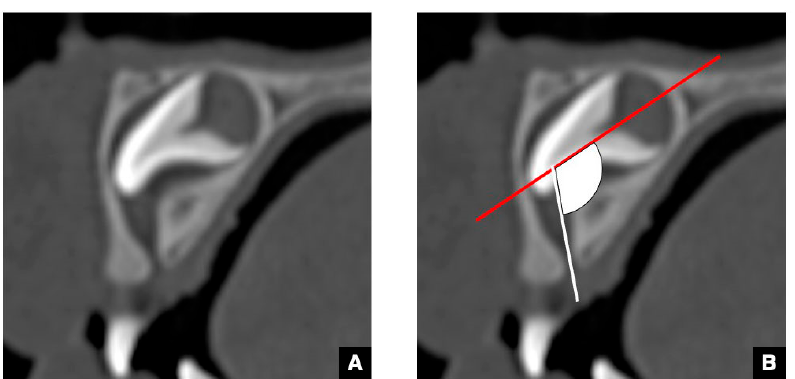
Figure 4. CBCT image ( A ) and illustration ( B ) of GT in the maxillary central incisor with delayed eruption. GT (arrow) of the maxillary central incisor with delayed eruption appears very similar to that with normal eruption on CBCT, but the angulation (fan) of the tract (line) to tooth axis (red line) tends to be greater than that with normal eruption on the sagittal image shown in Figure 1.